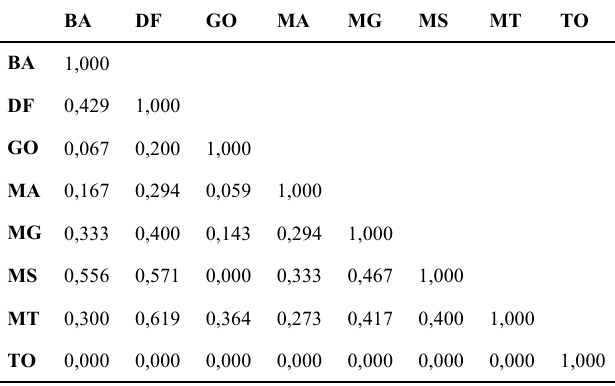
Brazilian savanna biome. Table 3. Similarity matrix (Jaccard) of species from the Polybia genus for the 8 studied states (BA = Bahia; DF = Distrito Federal; GO = Goiás; MA = Maranhão; MG = Minas Gerais; MS = Mato Grosso do Sul; MT = Mato Grosso; TO = Tocantins).